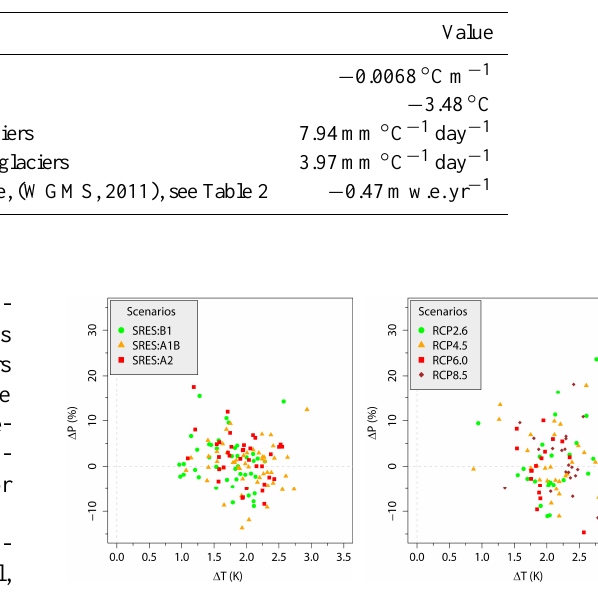
Figure 3. Range of projected changes (2021-2050 relative to 1961-1990) in yearly average temperature and precipitation in the upstream areas of the Amu and Syr Darya river basins. The left panel shows model runs used for the fourth assessment report of the IPCC (AR4) for three different emission scenarios (A1B (53 runs), A2 (36 runs), B1 (44 runs)). The right panel shows model runs that will be used for the fifth assessment report (AR5, all simulations available before 15 December 2011 are included) for four representative concentration pathways (RCP2.6 (26 runs), RCP4.5 (32 runs), RCP6.0 (17 runs), RCP8.5 (29 runs)). The plotted values are means over the values assigned to the grid cells of the climate models over the study region.